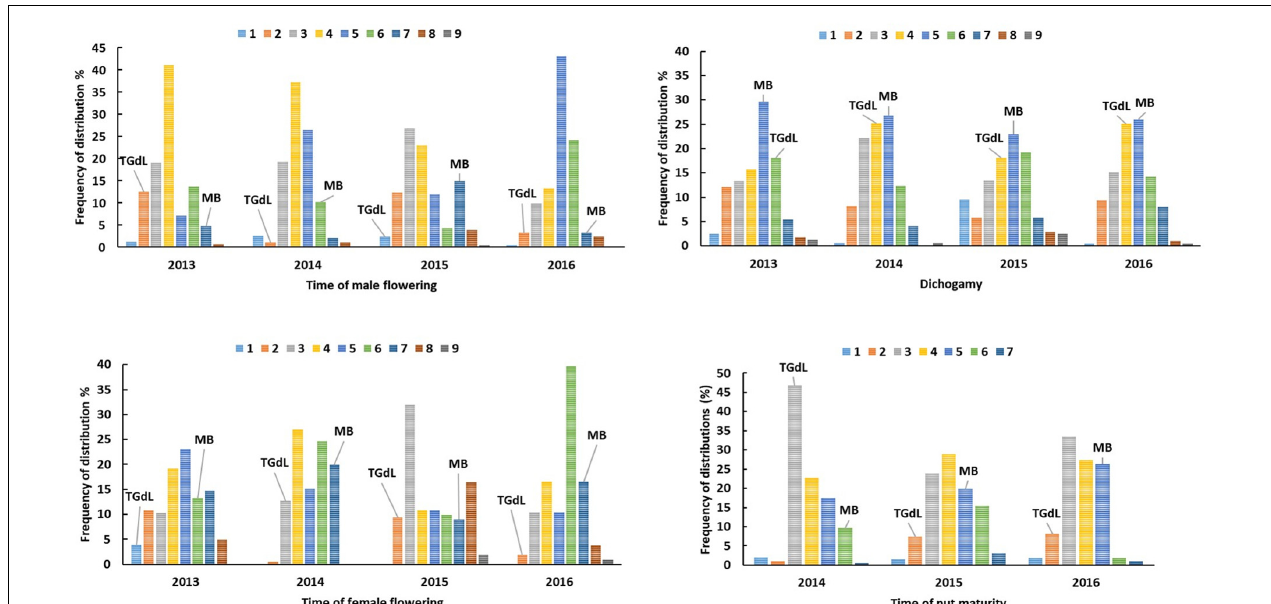
FIGURE 1 | Frequency distribution plot for the mapping population with respect to time of male flowering ( tmf ), time of female flowering ( tff ), dichogamy ( dc ) and time of nut maturity ( tnm ) over four seasons. Data are grouped in classes from 1 = very early to 9 = very late. For dichogamy ( dc ), data are grouped in classes from 1 = very protandrous to 9 = very protogynous (5 = homogamous). The positions (means of three individuals) of the parents TGdL and MB are shown in each